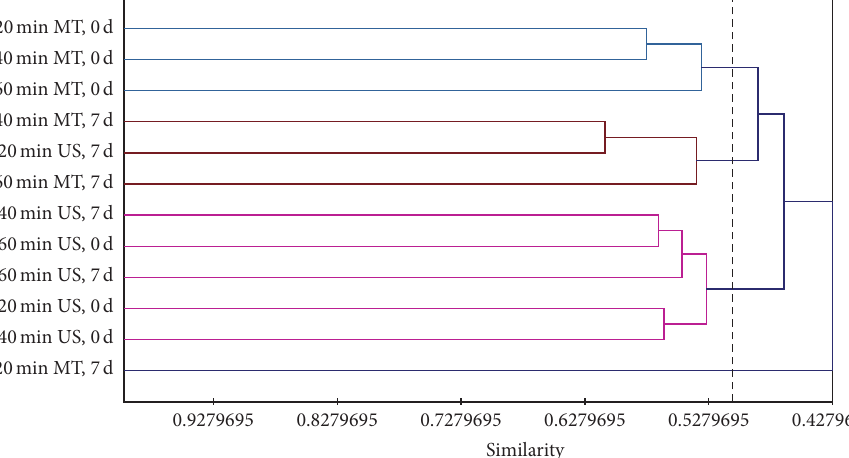
Figure 3: Categorization of beef samples (longissimus dorsi) using two types of marination processes. MT, marinated traditionally; US, ultrasound; d, storage days at 4 ∘ C. The sensory test was carried out using 24 consumers. The dashed line represents truncation in homogeneous groups.